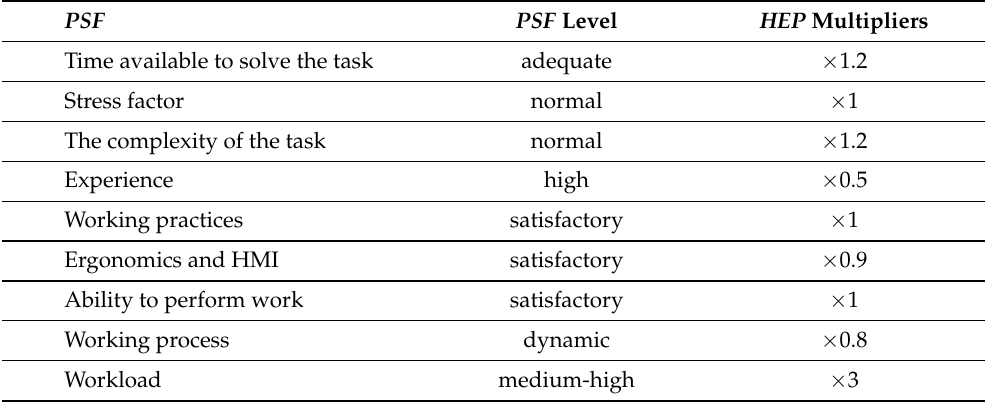
Table 6. PSF s overview for workplace B.